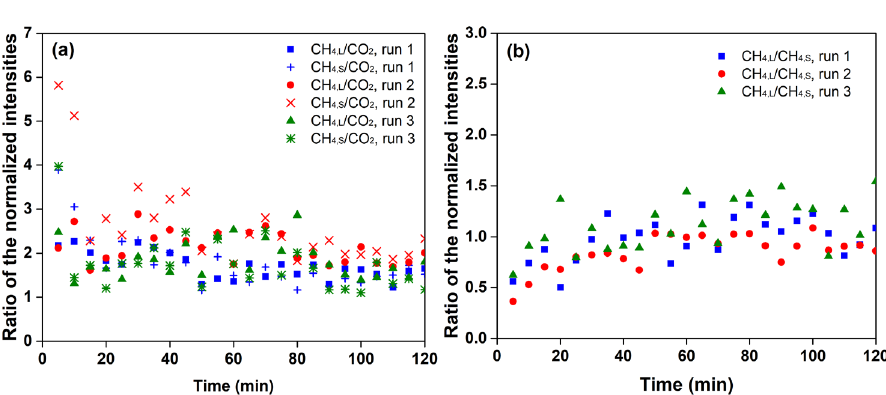
Figure 5. The ratio of the normalized intensities of CH 4 and CO 2 molecules and the CH 4 in the large and small cages in hydrate formation from synthesized biogas. The normalized intensities of CH 4 in large and small cages are labelled as CH 4,L and CH 4,S ,